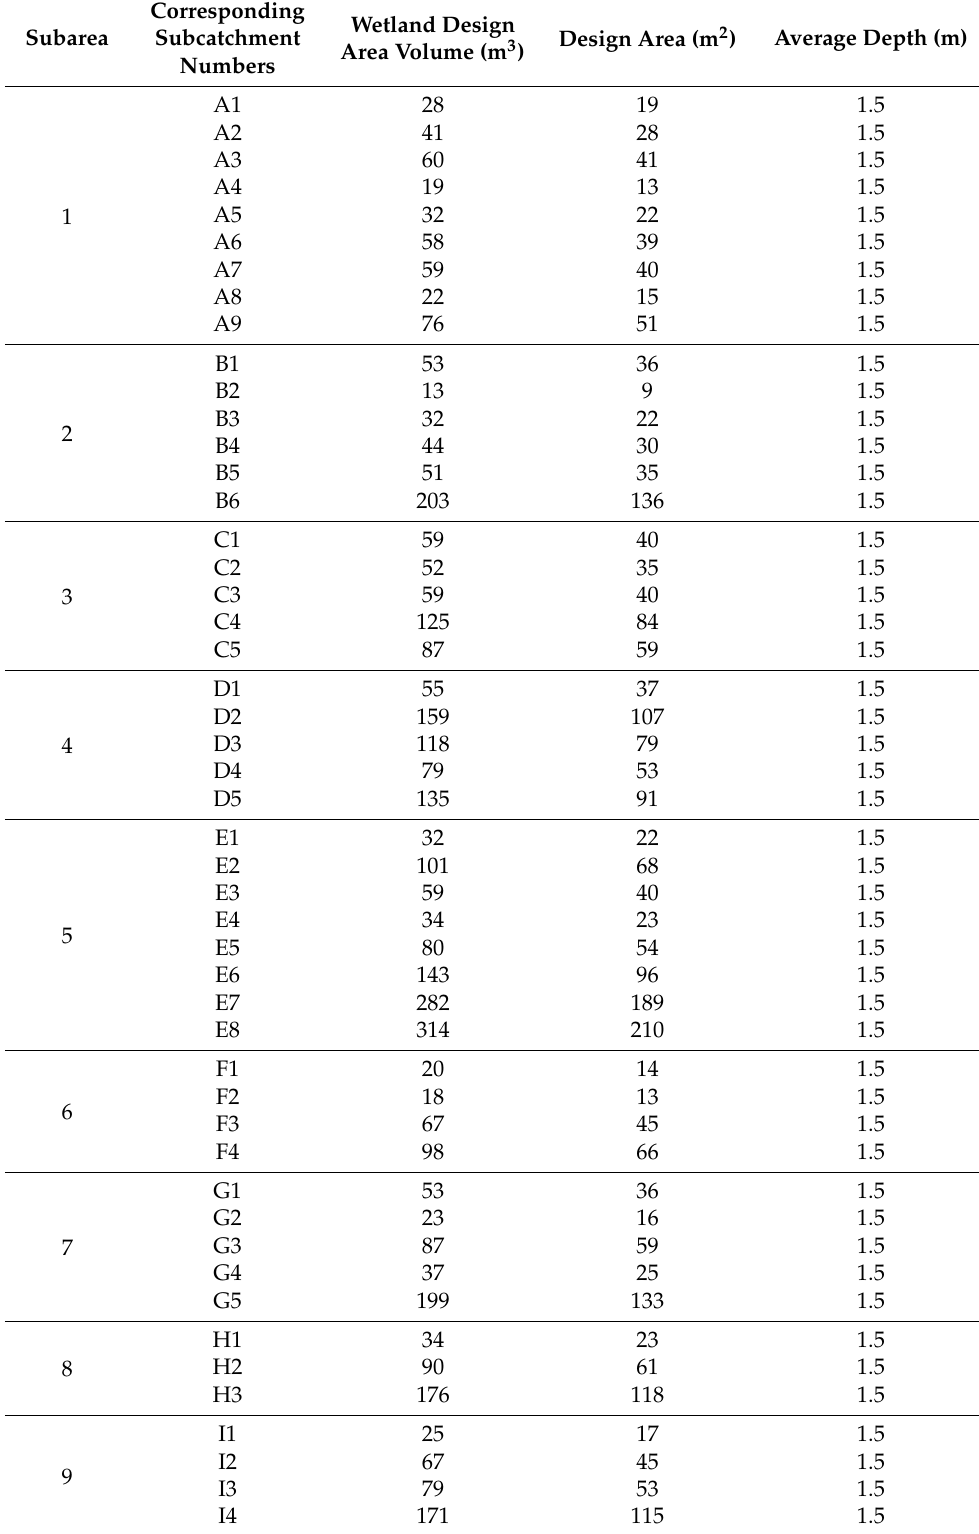
Table A1. Wetland parameters of the segmental detention and retention scheme (Scheme